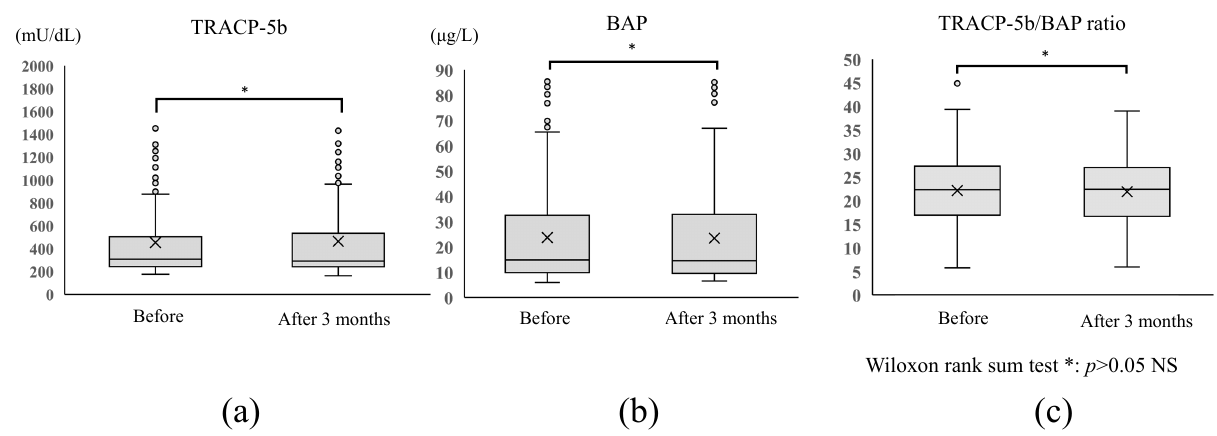
Figure 3. Changes in bone metabolism markers and bone turnover rate before and after administration of DNG 1 mg/day. No significant change was observed in ( a ) TRACP-5b (a bone resorption marker) or ( b ) BAP (a bone formation marker) before and after DNG 1 mg/day administration ( p < 0.05). ( c ) The bone turnover rate, TRACP-5b/BAP ratio, did not change significantly between before and after administration ( p < 0.05).